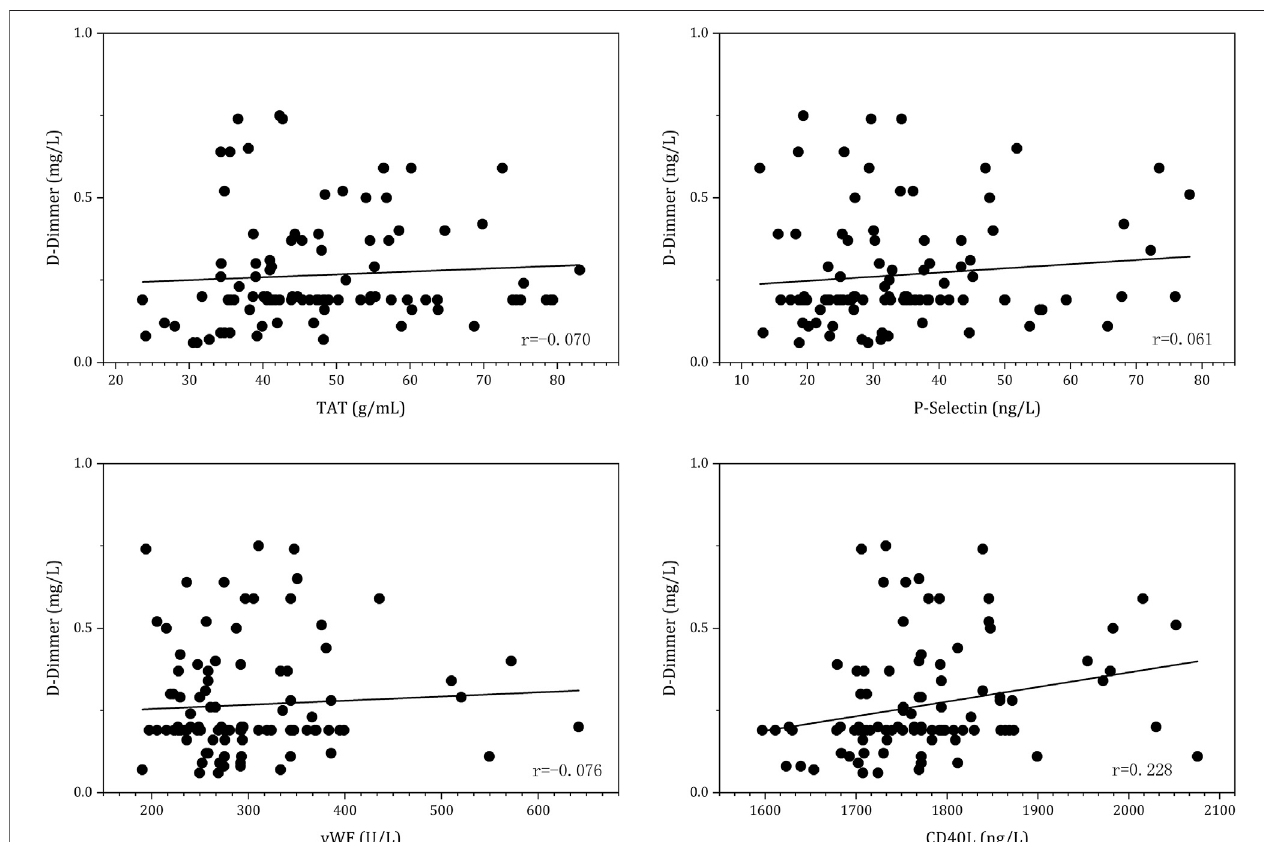
FIGURE 5 | Linear regression between D-dimer and platelet activation biomarkers under 3-month post-anticoagulation with DOAC agents.